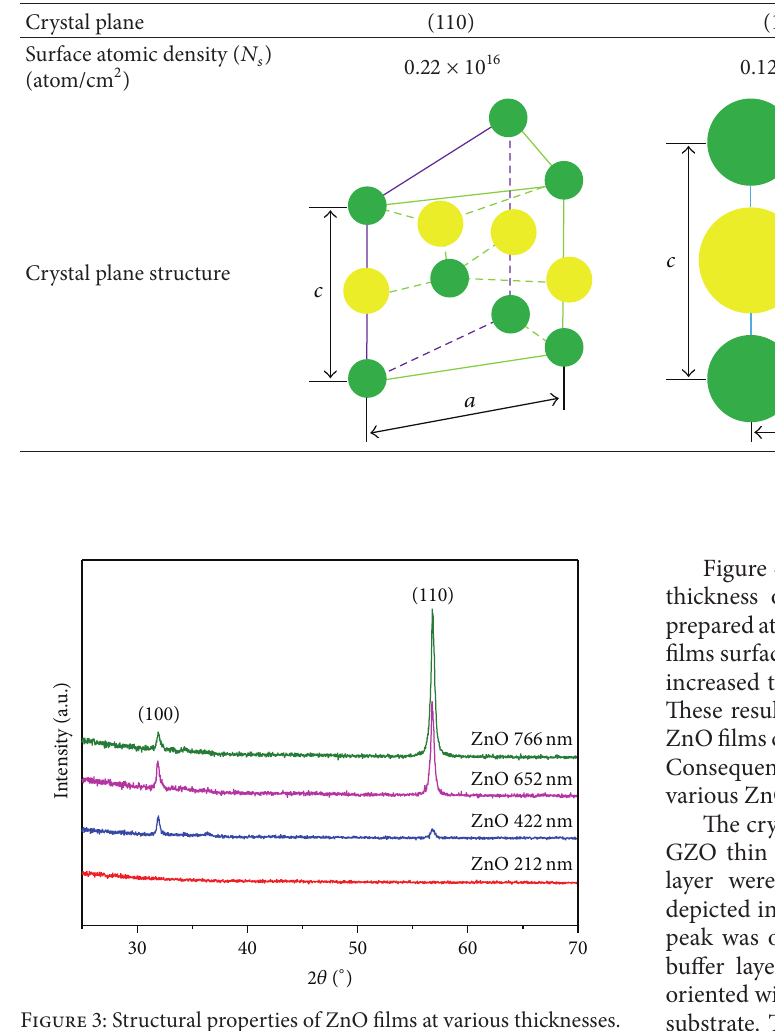
Table 1: The atomic density of some common planes for ZnO.